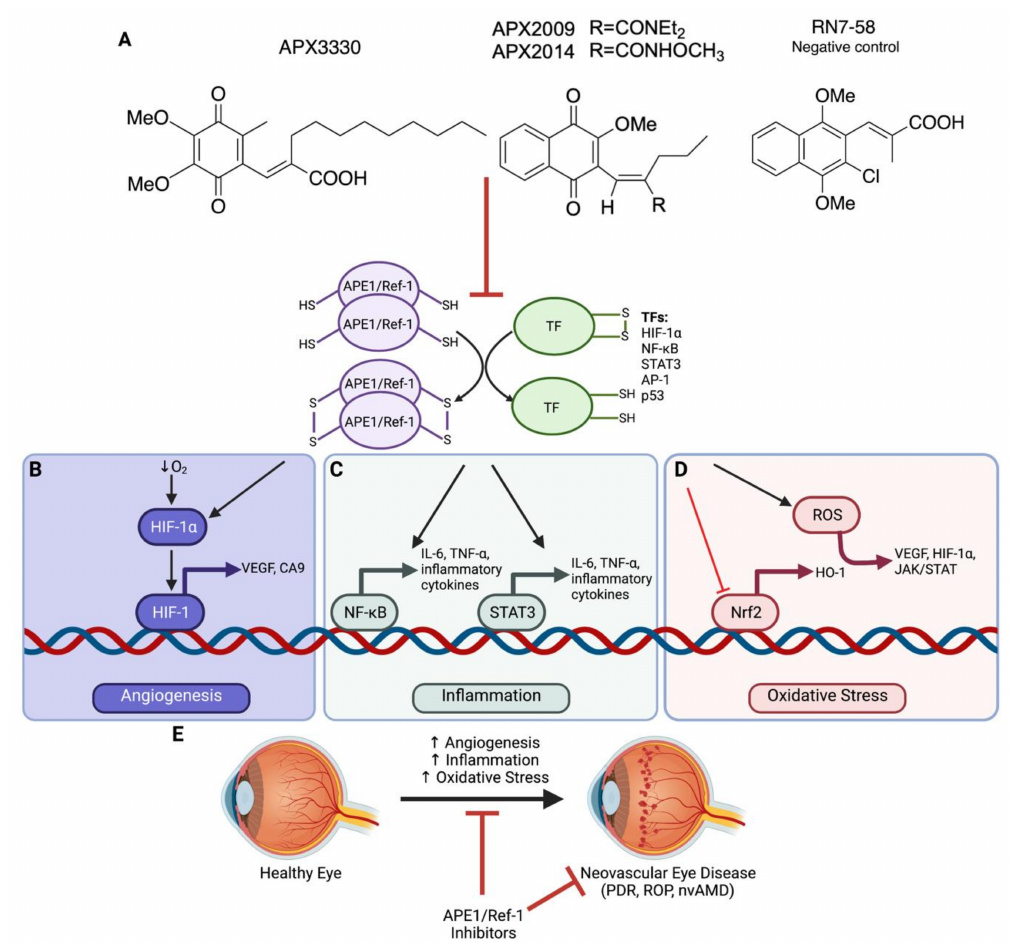
Figure 1. Role of APE1/Ref-1 in neovascular eye diseases. ( A ) APE1/Ref-1 redox function, inhibited by APX3330, APX2009 and APX2014, serves to regulate many transcription factors by reducing disulfide bonds of transcription factors to